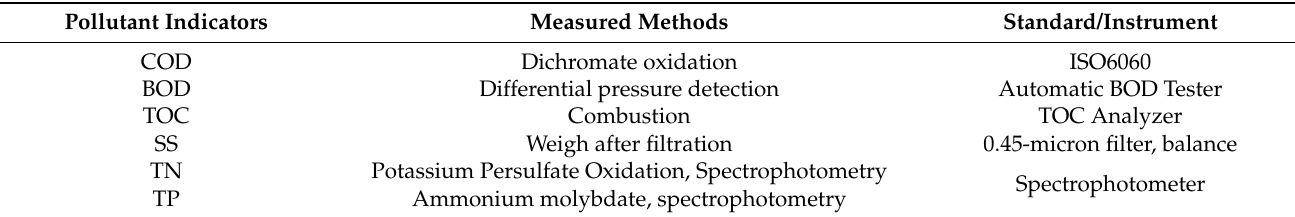
Table A1. Measured Methods of Common Biochemical